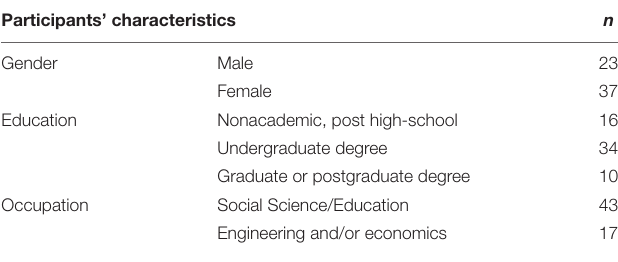
TABLE 1 | Participants’ Characteristics ( n = 60). Participants’